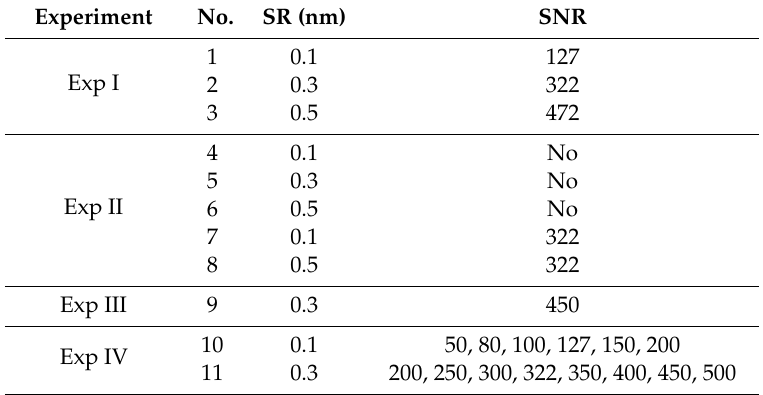
Table 4. Several simulated experiments with di ff erent combinations of SR and SNR. ‘No’ in the SNR column indicates that the simulated data do not include noise